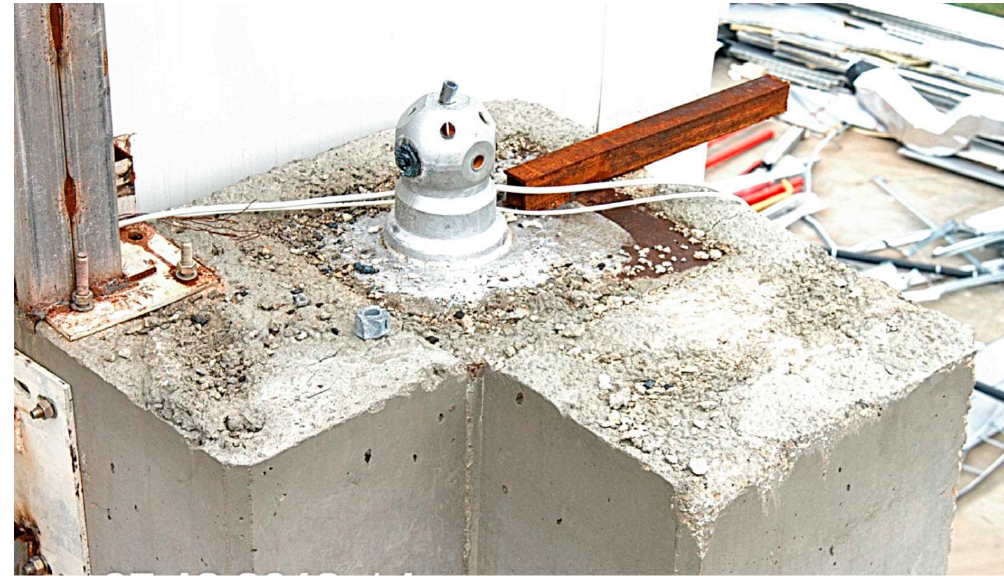
Figure 15. Damage on the support to which the space truss roof system was attached.